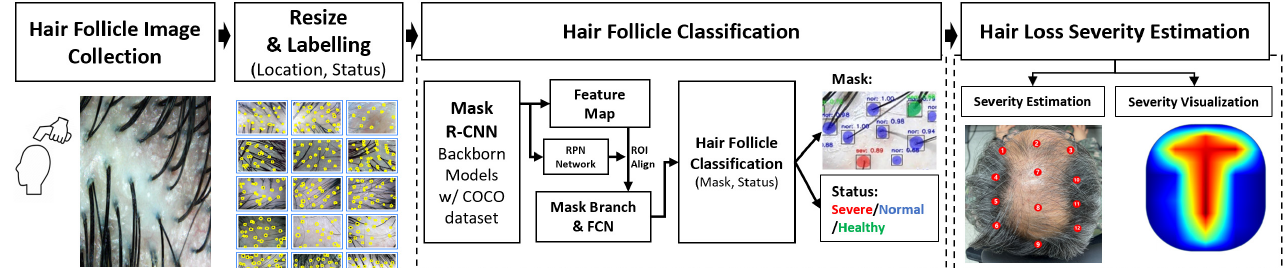
Figure 1. Model architecture of this paper.